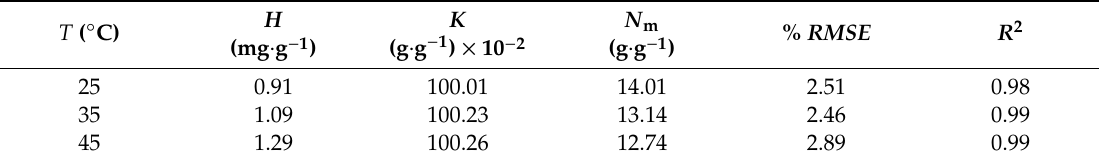
Table 2. Calculated parameters of the SLE model for adsorption isotherms of CTAB onto MgO